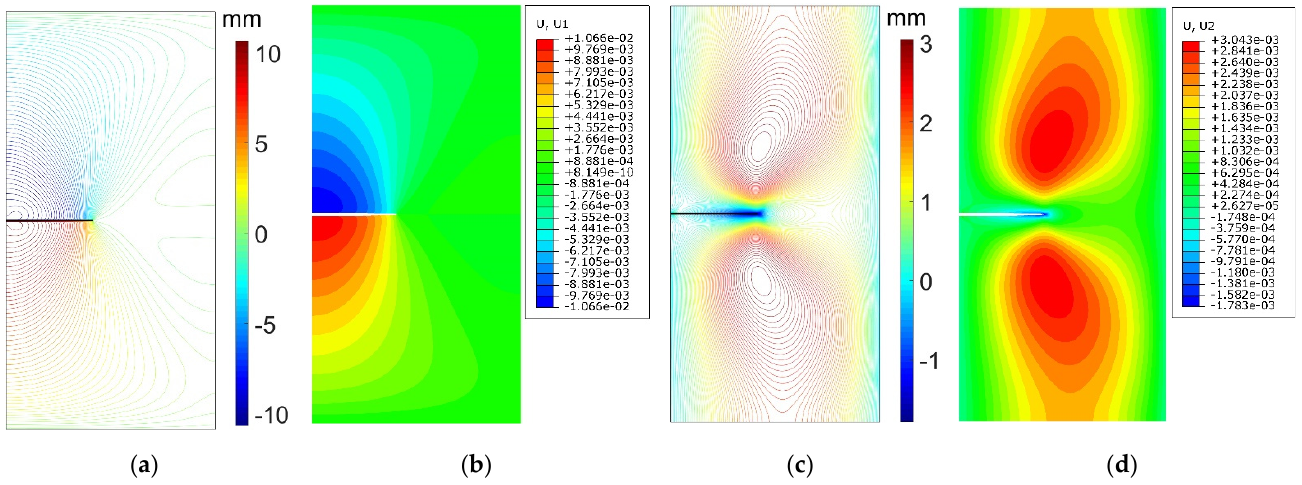
Figure 7. Distribution of displacement (t = 3.58 × 10 2 s): ( a ) u_yy by EDFM–XFEM model; ( b ) u_yy by FEM model; ( c ) u_xx by EDFM–XFEM model; and ( d ) u_xx by FEM model.